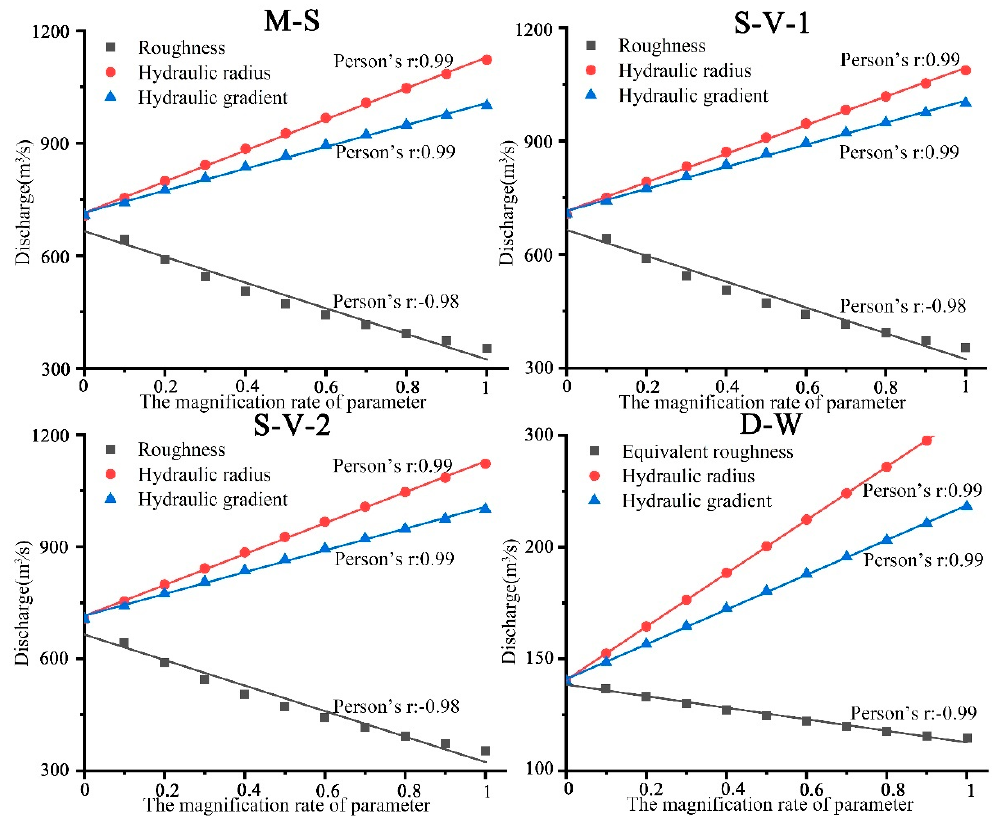
Figure 8. Parameter sensitivity analysis (control variates method).